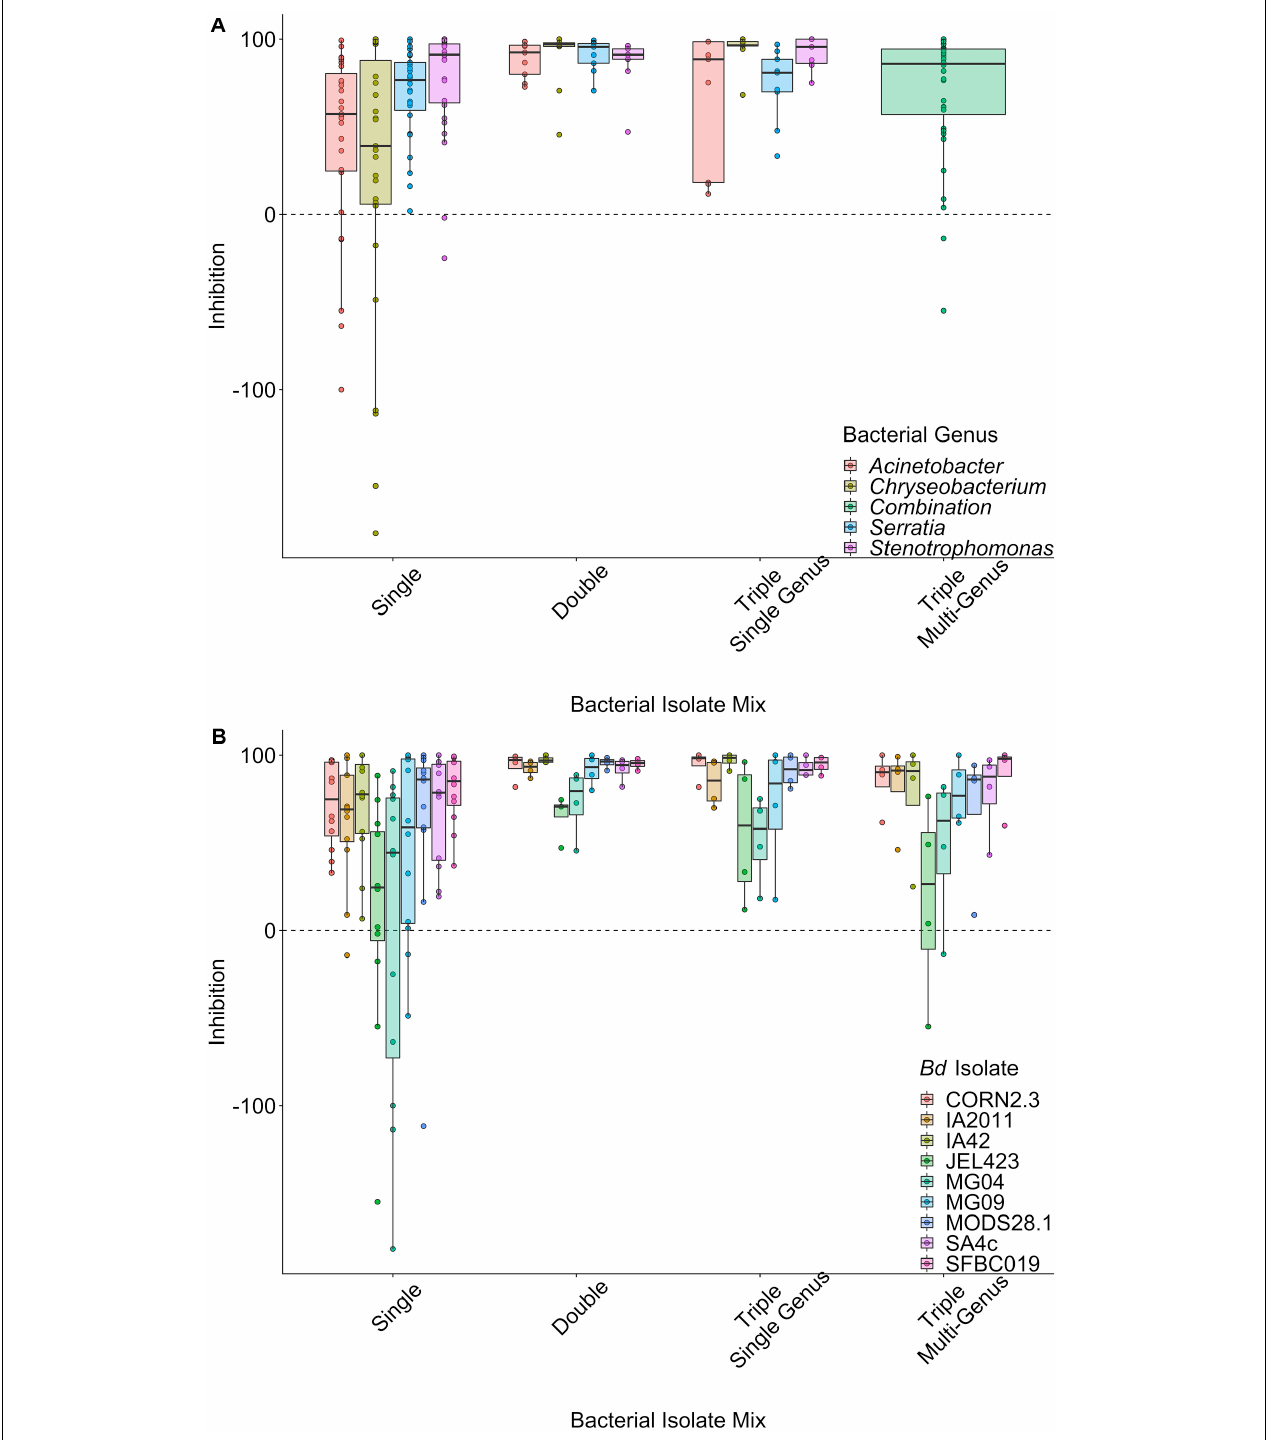
FIGURE 1 | Raw data plots of inhibition scores split by probiotic type, grouped by (A) bacterial genus averaged over B. dendrobatidis ( Bd ) isolates and (B) Bd isolates averaged over bacterial genus. Data are displayed as boxplots with raw data points overlaid. Positive values (above the dashed line) indicate inhibition of Bd growth, whereas negative values indicate that Bd grows faster in the presence of the probiotic. There is clear variation in inhibition strength across Bd isolates and probiotic types.